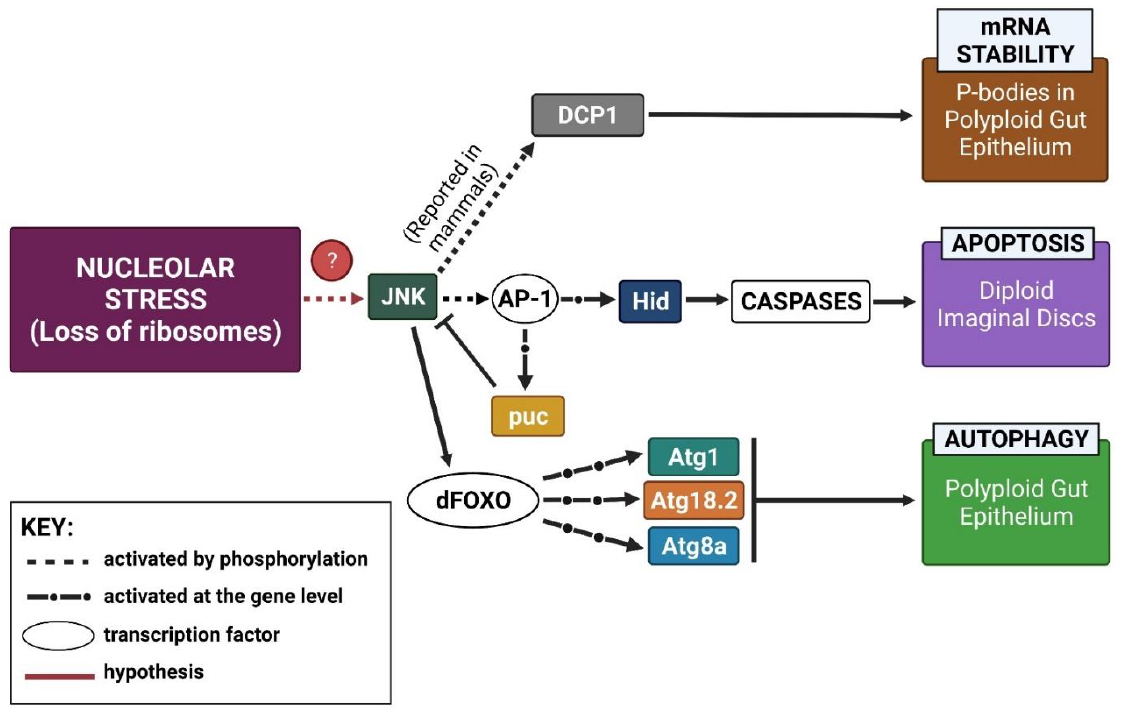
Figure 7. Our current working model of nucleolar stress in Drosophila induced by the loss of ribosome biogenesis factors. Various cell stress responses are tissue specific, but all are predicted to be JNK-dependent. Autophagy was visible by TEM in the Drosophila gut epithelium upon loss of NS1 and NS2 [27,28] while apoptosis occurred in diploid imaginal wing disc cells upon loss of Nopp140 [30]. This report showed that upon complete loss of Nopp140 by gene deletion, JNK was activated leading to the up-regulations in puc, Hid, Atg1, Atg18.2, and Atg8a. We know that activated JNK regulates the formation of P bodies in mammalian cells by phosphorylating DCP1 [59]. We have yet to establish this JNK-DCP1 link in Drosophila and to link the activation of JNK to nucleolar stress via several different upstream kinases.